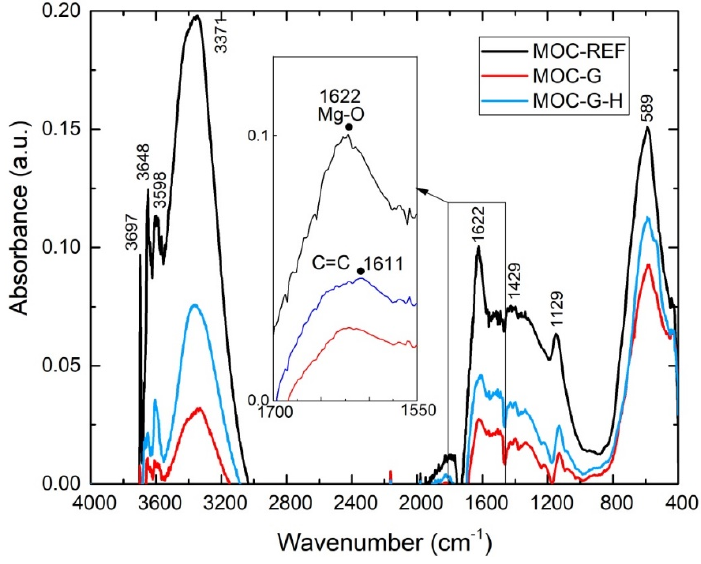
Figure 8. The MIR spectrum of MOC 5-1-8 phase in the range of 400–4000 cm − 1 . Table 2. Assignments of the major absorption bands of MOC The analyzed spectrum of graphene evidences only one weak band appearing at